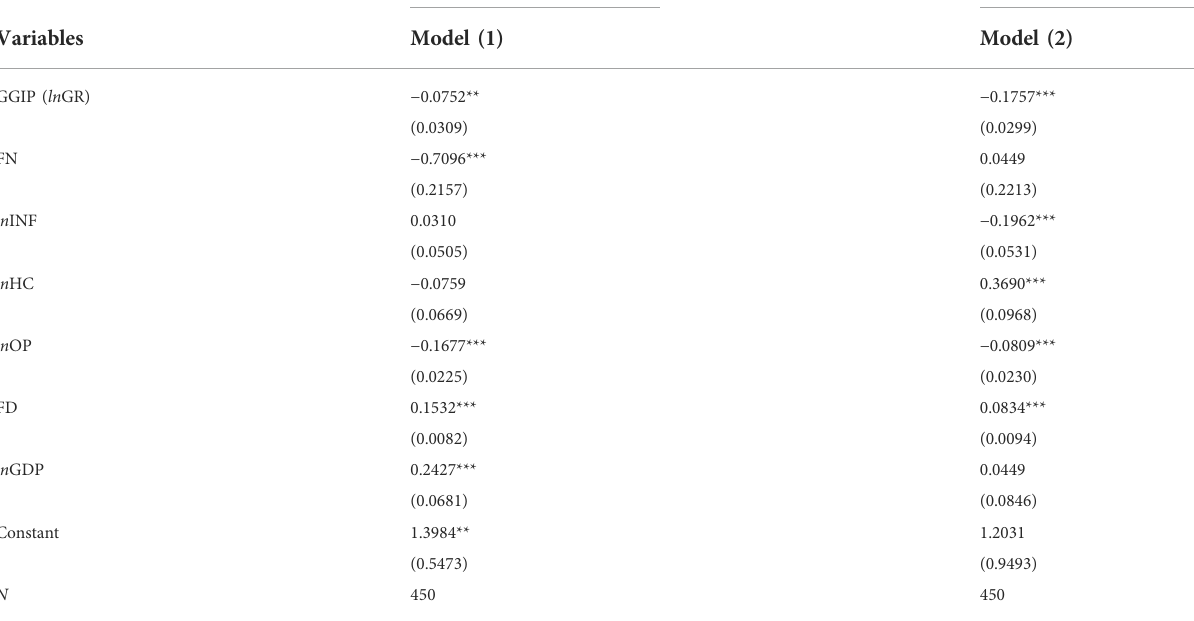
TABLE 4 Panel regression output: Random- and fi xed effect.